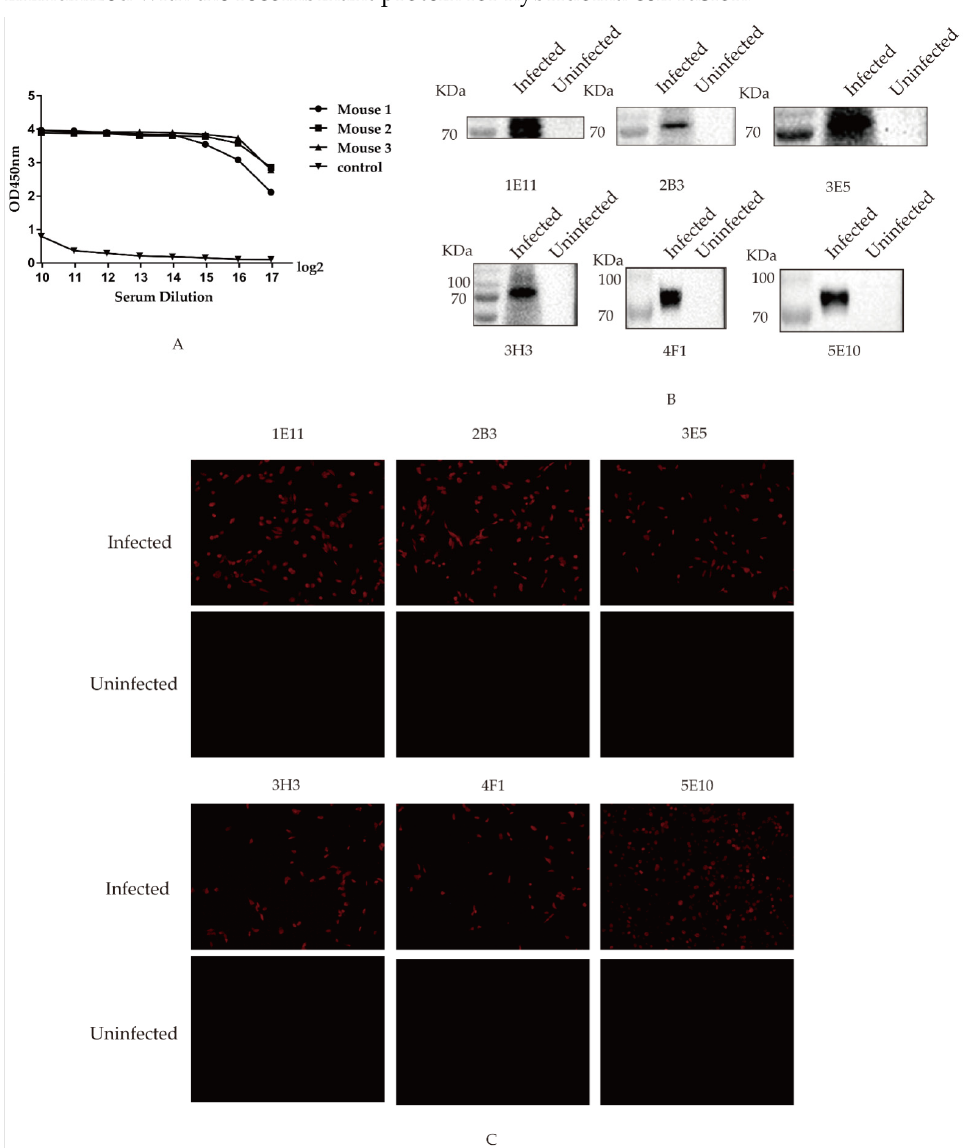
Figure 2. Screening and identification of monoclonal antibodies: ( A ) antibody levels of the immunized mice. At one week after the third immunization, the antibody potency of the immunized mice was detected, and presented as the absorbance value of OD 450 nm ; ( B ) relationship between mAbs 1E11, 2B3, 3E5, 3H3, 4F1, and 5E10 and AIV-infected cells. A549 cells were infected with AIV, and the protein samples were collected at 24 hto detect recognition between HA protein and mAbs by western blotting; and ( C ) reactivity of six mAbs detected by the indirect immunofluorescence. MDCK cells were infected with AIV and incubated with the screened mAbs to detect the reactivity’s mAbs with HA protein of AIV with indirect immunofluorescence. The HA protein was marked in